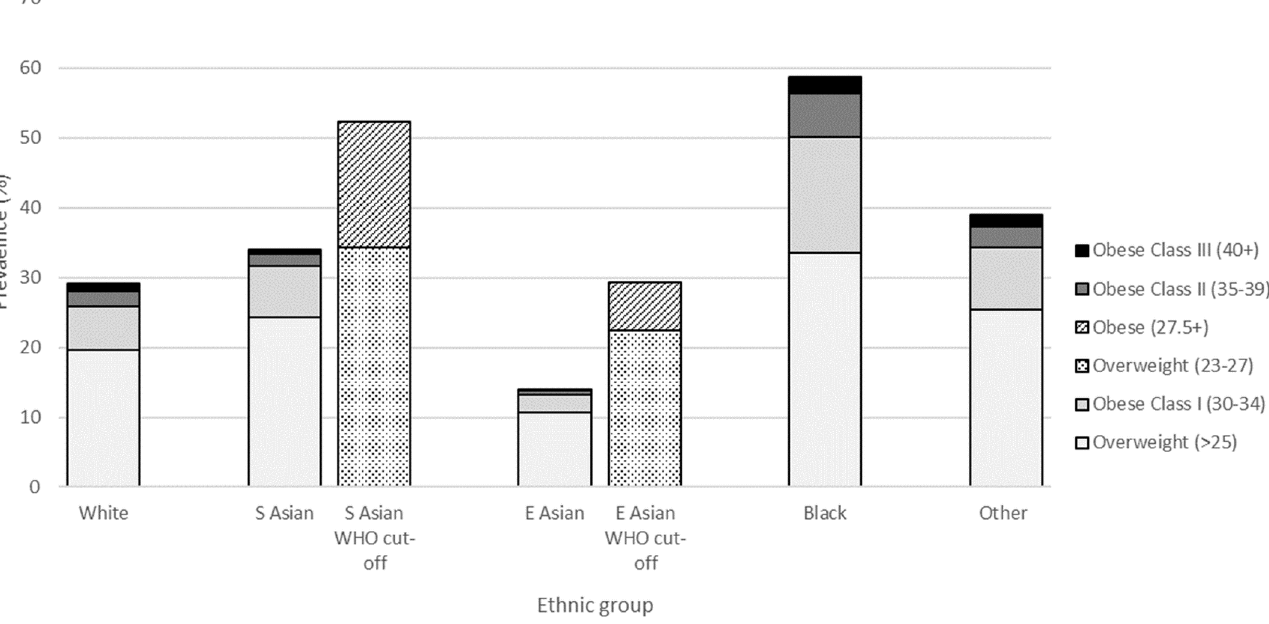
PLOS ONE | https://doi.org/10.1371/journal.pone.0179332 June 22,